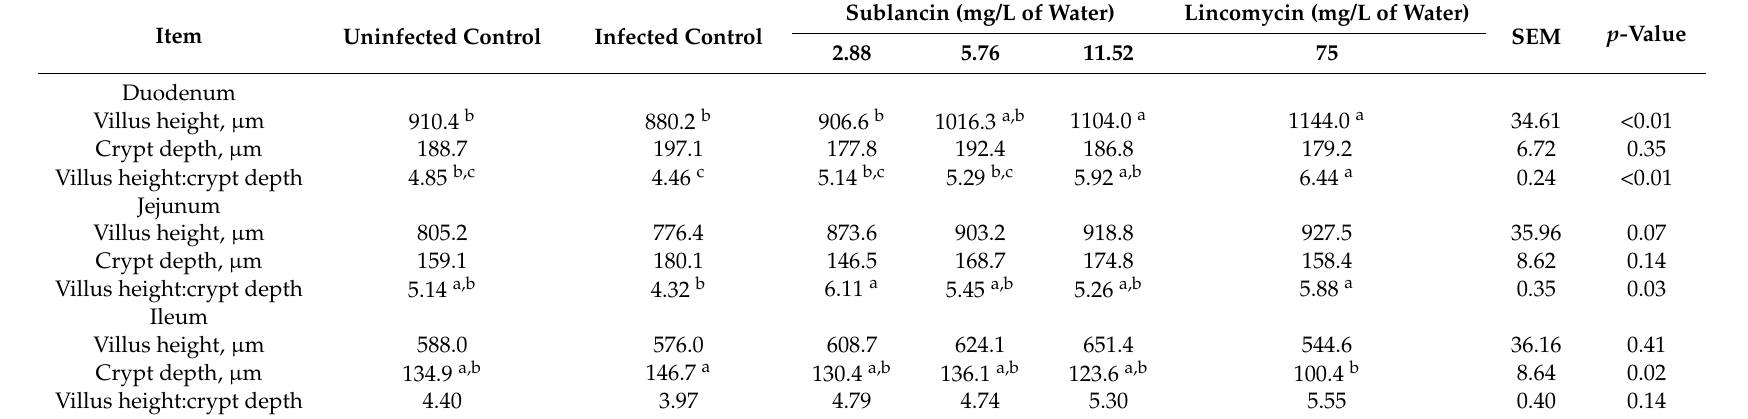
Table 2. The effect of sublancin on small intestinal morphology of broilers challenged with Clostridium perfringens (day 28) 1,2